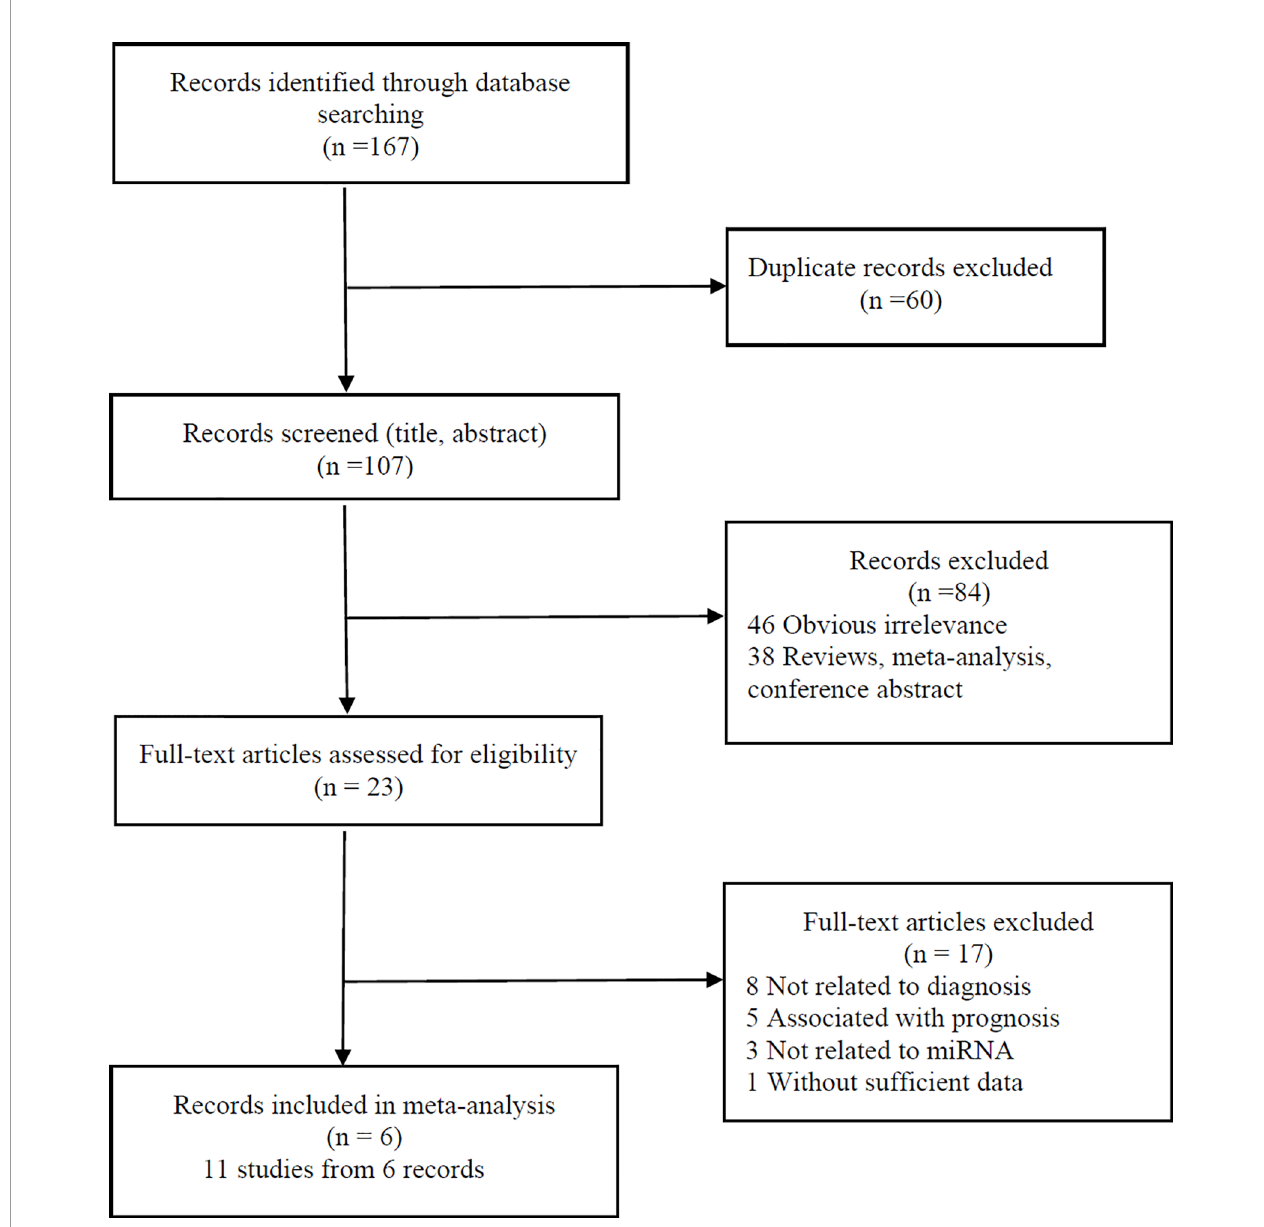
FIGURE 1 | Flow diagram of study selection